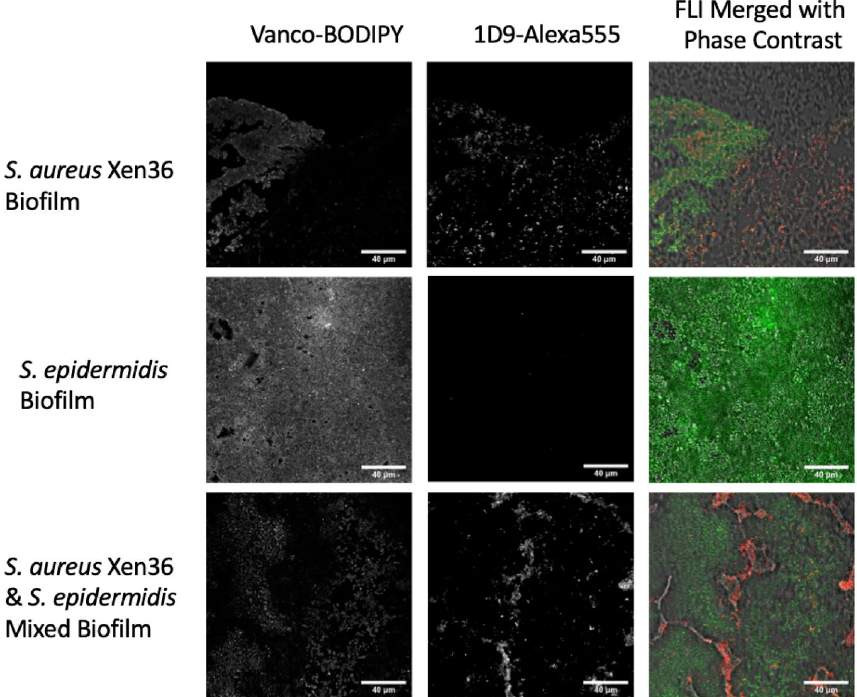
Figure 1. Imaging of staphylococcal biofilms with vancomycin- and 1D9-based fluorescent probes. Biofilms of S. aureus Xen36 , S. epidermidis ATCC 38984 , or a mixture of both Staphylococcus species were grown on cover slides for confocal microscopy. The established biofilms were simultaneously incubated with the Vanco-BODIPY and 1D9-Alexa555 probes. Subsequently, images were recorded by confocal fluorescence microscopy, revealing binding of the vancomycin probe to all biofilms and the 1D9-Alexa555 probe to S. aureus biofilms only. Of note, we attribute the “patchy” fluorescence pattern of the S. aureus cells in the mixed biofilm, as detected with the